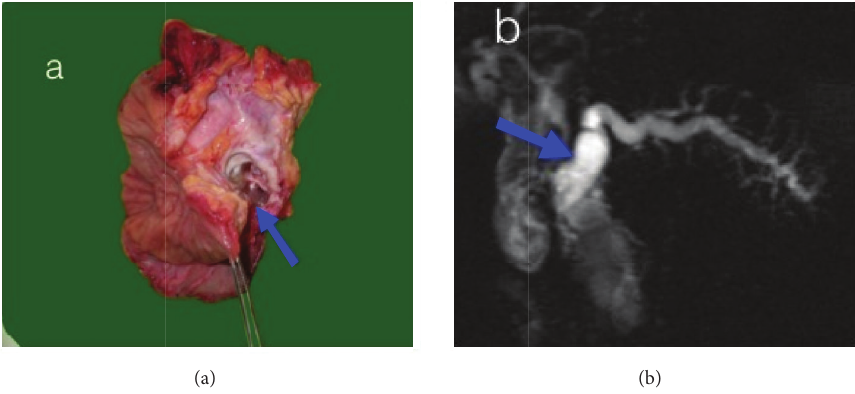
Figure 4: Surgical specimen is possible to appreciate a clear correspondence between the specimen (a) and the imaging findings (b). The histological result was IPMN adenocarcinoma. The blue arrow indicates the